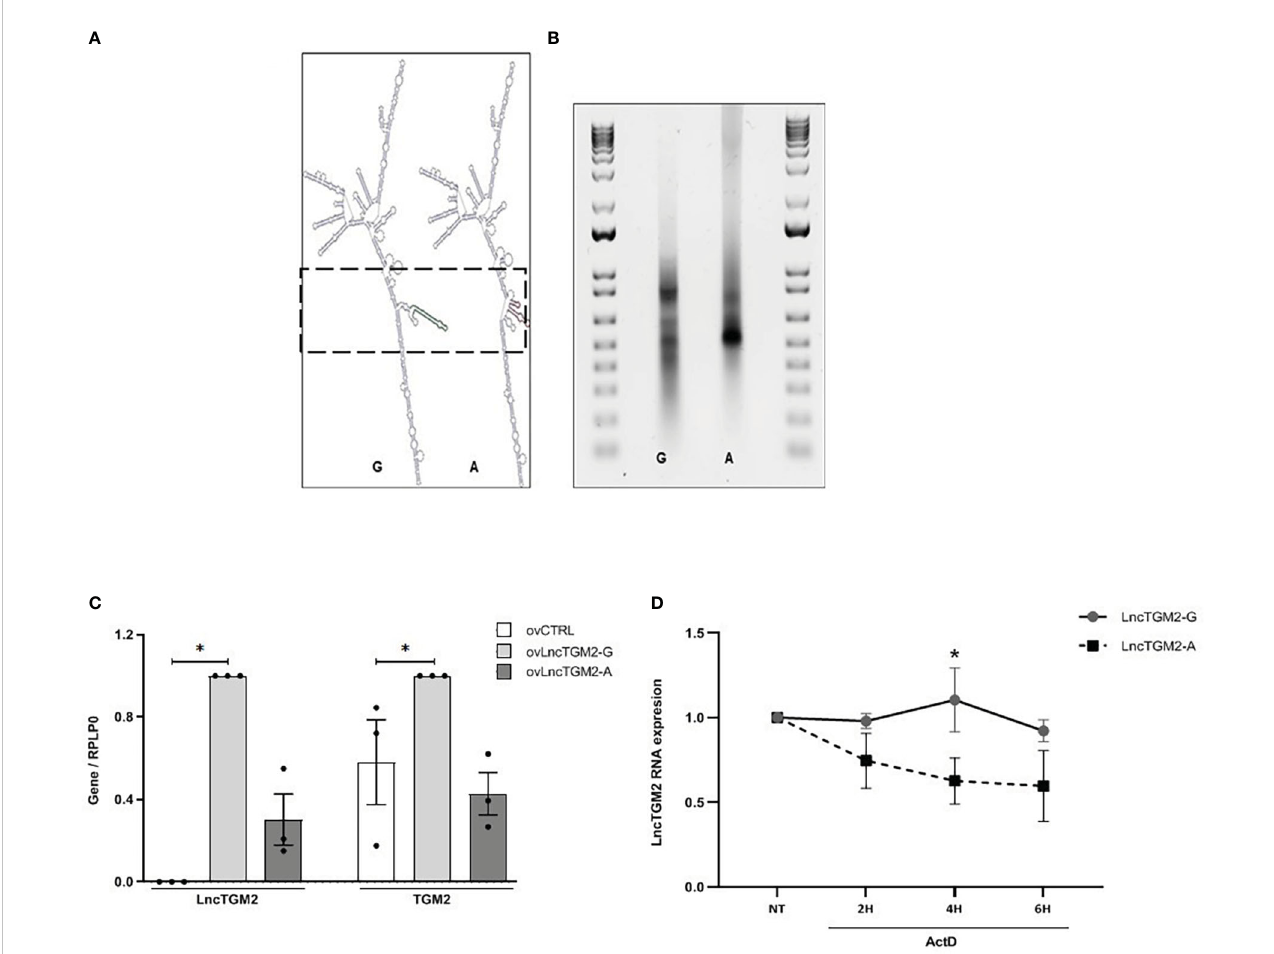
FIGURE 3 The T2D-associated risk allele in LncTGM2 disrupts its secondary structure impacting on its stability, and correlates with decreased expression of TGM2 in beta cells. (A) In silico prediction of the secondary structure of LncTGM2 harboring each allele for rs2076380; T2D protective allele (G) or T2D risk allele (A) . (B) Electrophoretic mobility pro fi les of in vitro -transcribed LncTGM2 molecule harboring the T2D protective allele (rs2076380-G) or the risk allele (rs2076380-A). (C) EndoC- b H1 cells were transfected with overexpression plasmids of LncTGM2 harboring the protective (ov LncTGM2 -G) or risk allele (ov LncTGM2 -A) for T2D, and mRNA levels of LncTGM2 and TGM2 were determined by RT-qPCR and normalized to RPLP0. The results are means ± S.E.M. of 3 independent experiments; *p < 0.05 by Student ’ s t-test. (D) EndoC- b H1 cells were transfected with LncTGM2 overexpression plasmids harboring the protective (ov LncTGM2 -G) or risk allele (ov LncTGM2 -A) for T2D. EndoC- b H1 cells were exposed to Actinomycin D (ActD) (5 m g/ml) for 2, 4 or 6h and LncTGM2 mRNA level was determined by RT-qPCR. The results are means ± S.E.M. of 3 independent experiments. *p < 0.05 ov LncTGM2 -G vs. ov LncTGM2 - A at the same